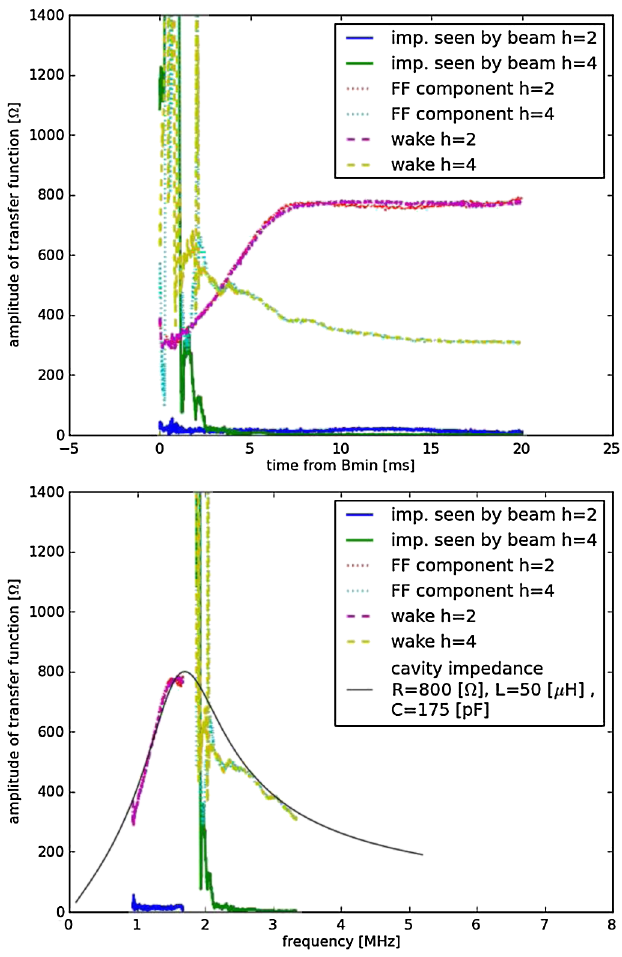
FIG. 15. The comparison of the impedances and the feedfor- ward transfer function of cavity#1—(top) as function of time, (bottom) translation to frequency domain. In the frequency domain, the impedance of a parallel LCR circuit is also